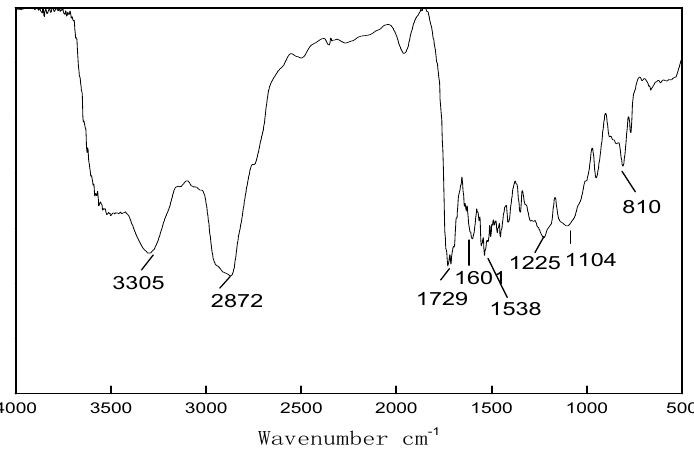
Figure 2. FT-IR spectra of water-borne polyurethane acrylate modified by hyperbranched silicon.